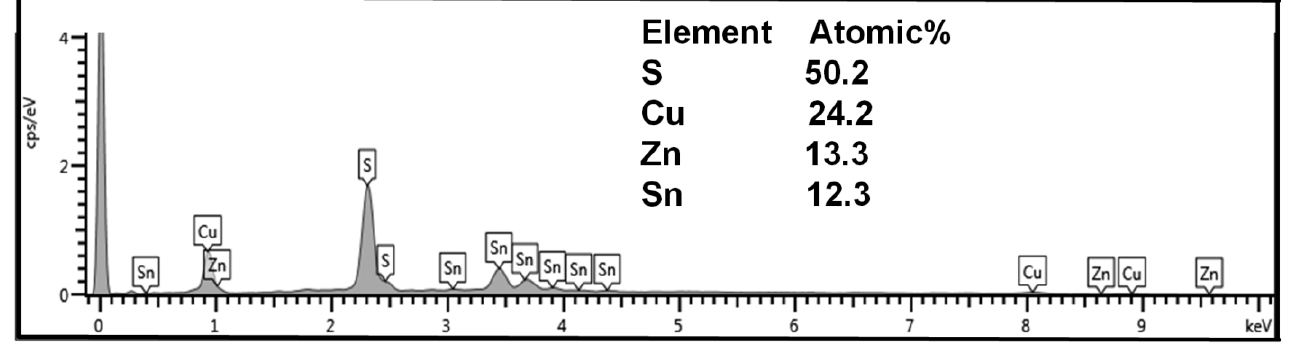
Figure 4. Field emission scanning electron micrographs of the Cu 2 ZnSnS 4 (CZTS) layer surfaces pre- pared using 1,8-diiodooctane (DIO) additive concentrations of ( a ) 5, ( b ) 10, ( c ) 15, and ( d ) 20 mg/mL.